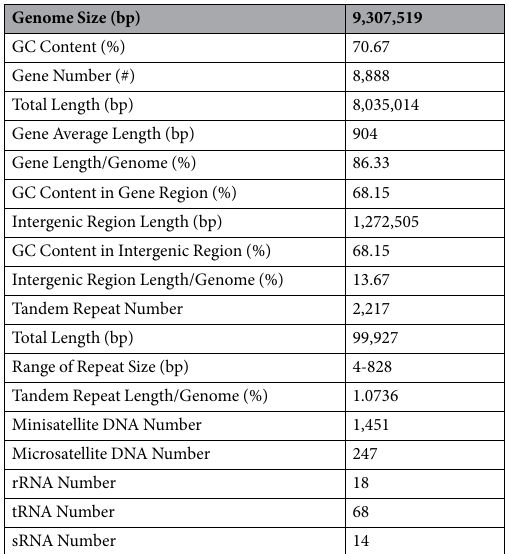
Table 1. Characteristics of the S . lydicus A02 genome assembly using single-molecule real-time